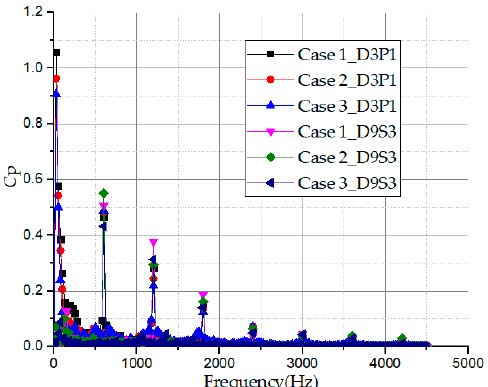
( c ) Outflow Figure 20. Frequency domain history of pressure fluctuation coefficient in side channel passage for